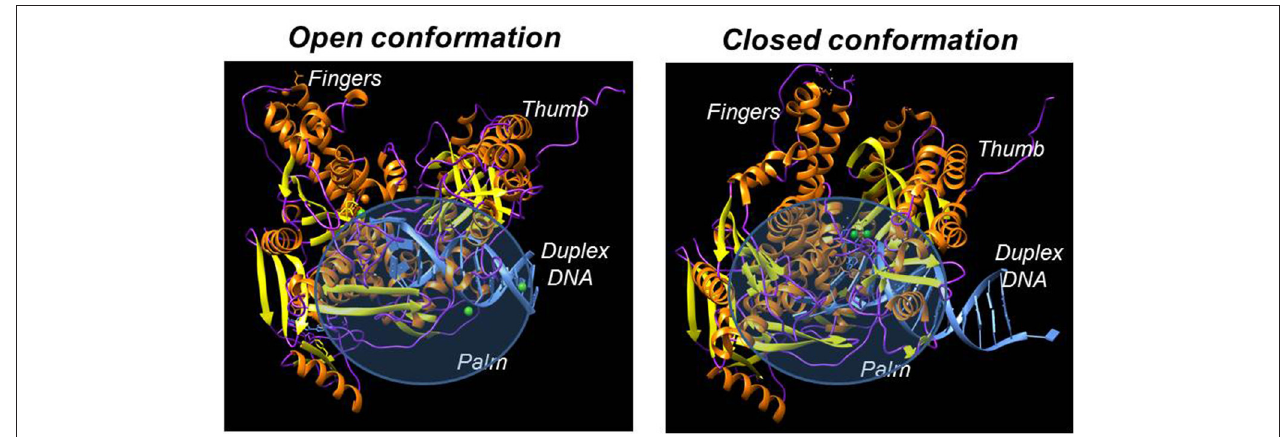
FIGURE 2 | X-ray crystallographic structures of DNA polymerases reveal common structural motifs representing the palm, fingers, and thumb subdomains that play important roles in nucleotide binding and phosphoryl transfer. The left panel displays the structure of a high-fidelity DNA polymerase (bacteriophage RB69) in the “open” conformation while the right panel displays the structure of the polymerase in the “closed” conformation.